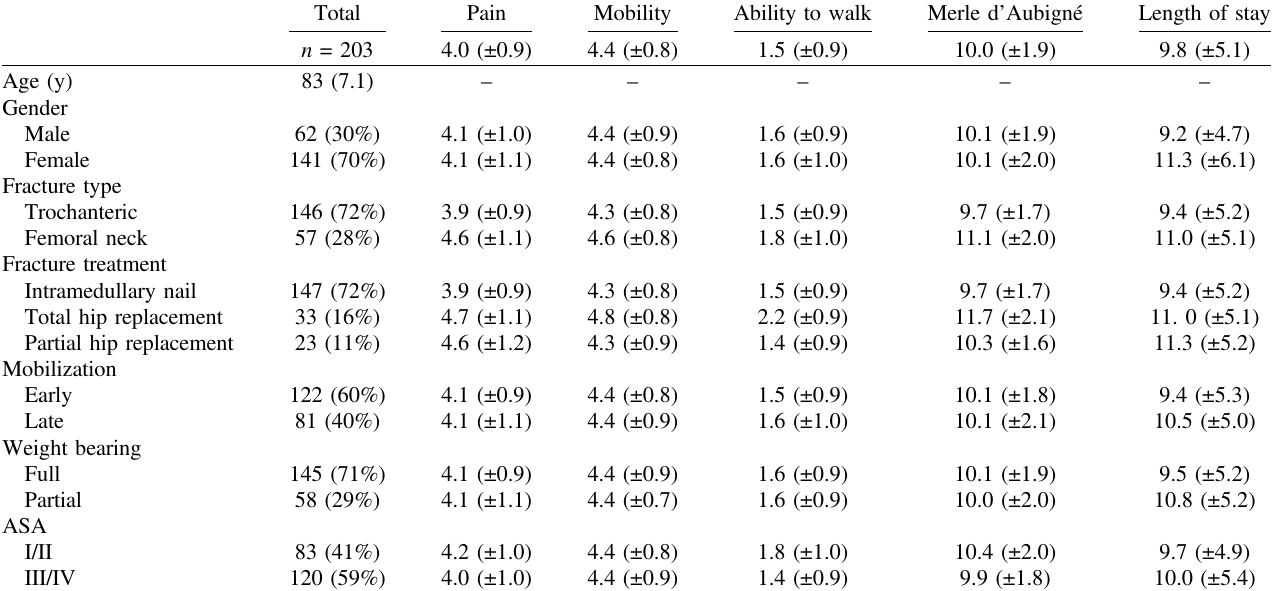
Table 3. Overview.